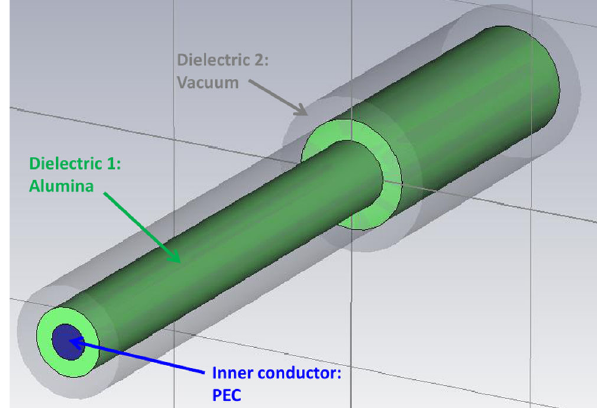
electrodes.FIG. 16. Schematic of one of the Kyocera feedthroughs [20] used to connect the electrodes with the inductive adder and the loads.